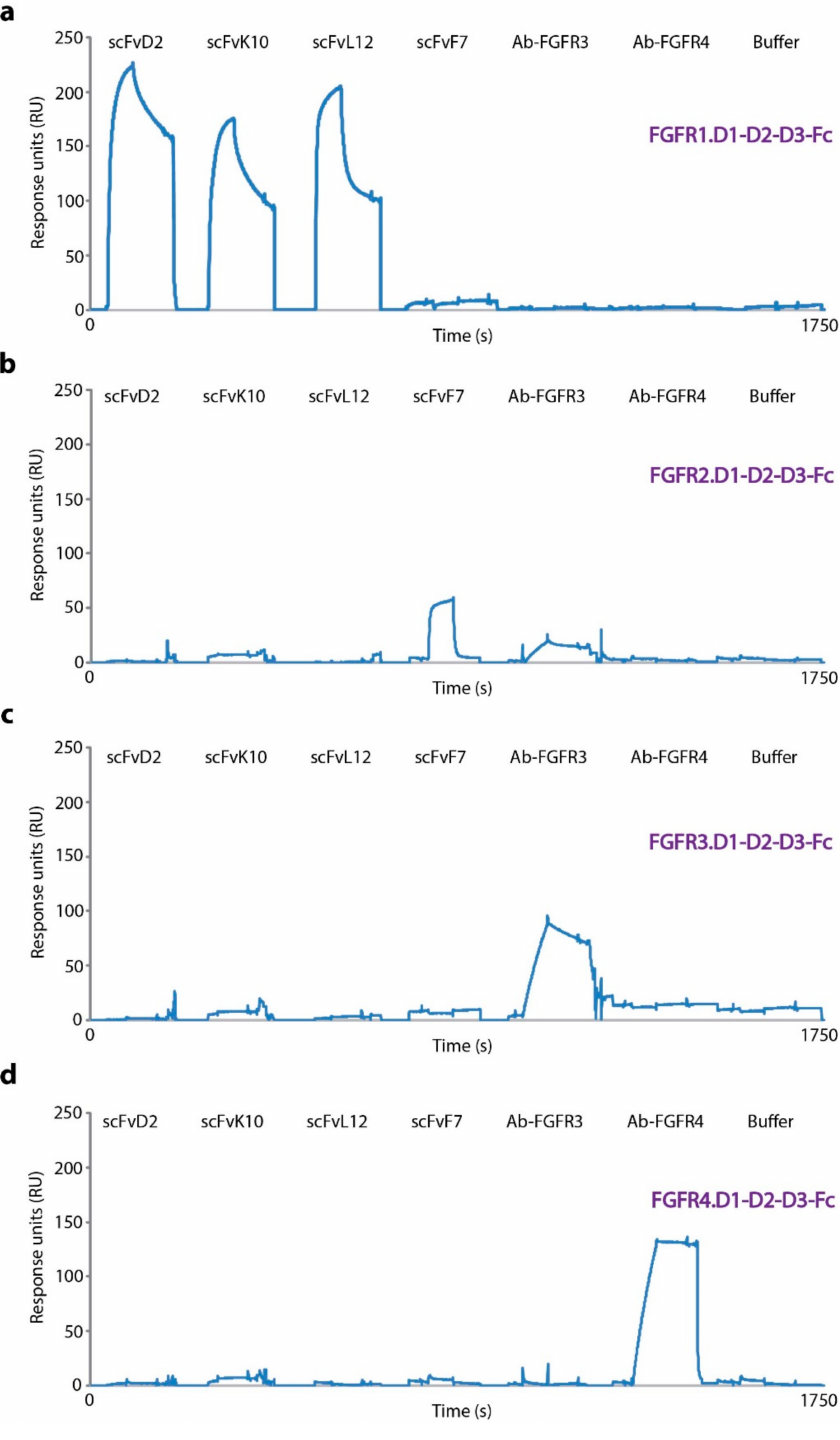
Figure 2. Specificity of scFv proteins towards FGFR1. Extracellular regions of FGFR1 (FGFR1.D1-D2-D3-Fc ( a ); FGFR2 (FGFR2.D1-D2-D3-Fc ( b ); FGFR3 (FGFR3.D1-D2-D3-Fc ( c ); and FGFR4 (FGFR4.D1-D2-D3-Fc ( d ); were immobilized on CM5 sensors and incubated with scFvD2, scFvL10, scFvK12, scFvF7 (specific towards FGFR2), and commercial anti-FGFR3 and anti-FGFR4